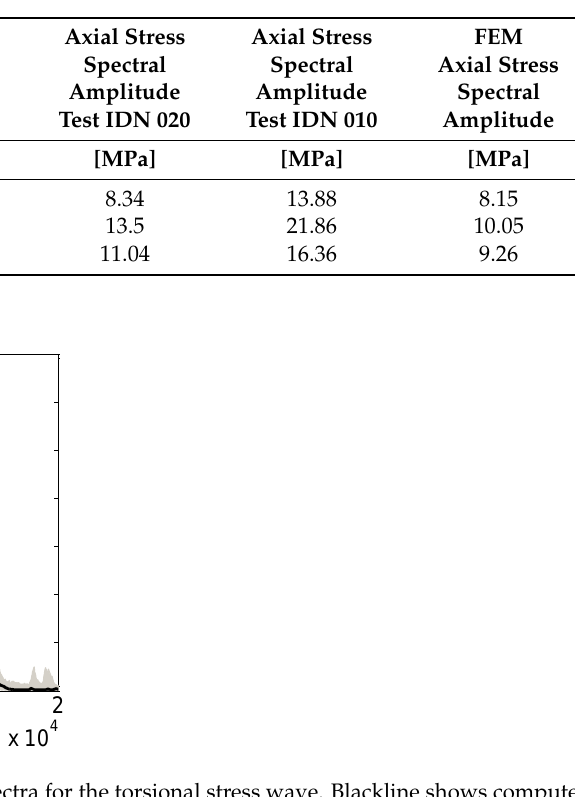
Figure 11. Measured and computed spectra for the axial stress wave. Black, light grey, and dashed dark grey show computed axial stress by means of the FE model and the ones measured in tests 020 and 010, respectively. Table 8. Comparison between measured and computed axial frequencies and relative spectral amplitudes. Measured values refer to tests IDNs 020 and 010.